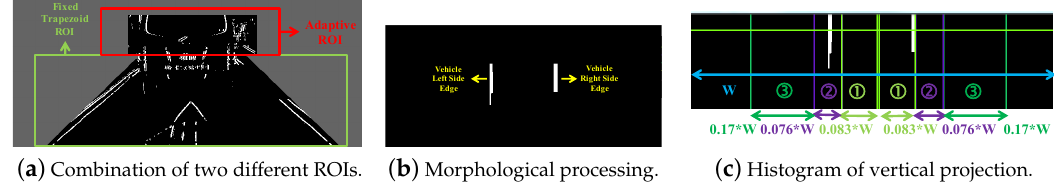
Figure 4. The front vehicle detection using a vertical edge pair. A combination of an adaptive ROI and a fixed trapezoid is